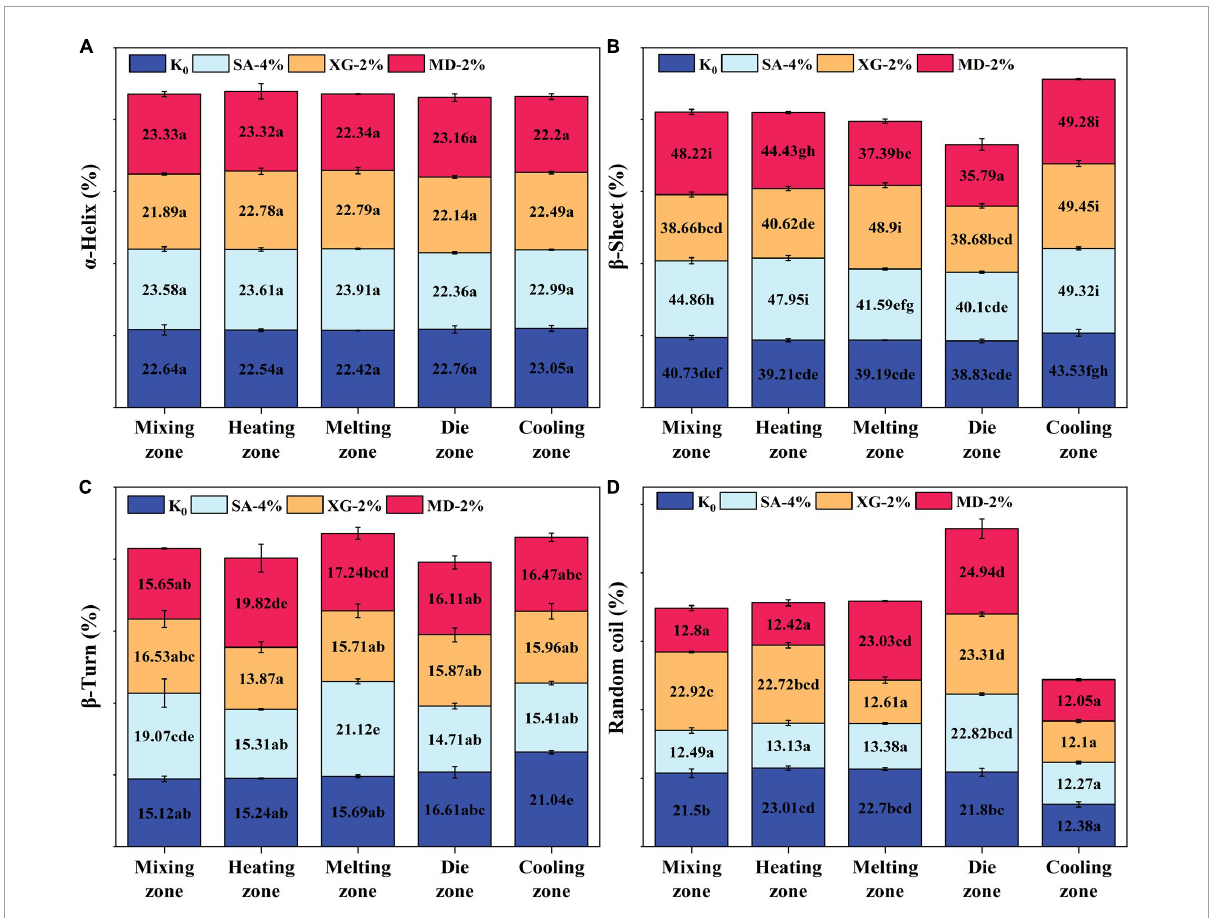
FIGURE5 Relative proportion changes of protein secondary structures for extrudates of different zones. (A) α -Helix, (B) β -Sheet, (C) β -Turn, and (D) Random coil. Different letters imply significant differences between different samples ( P < 0.05).